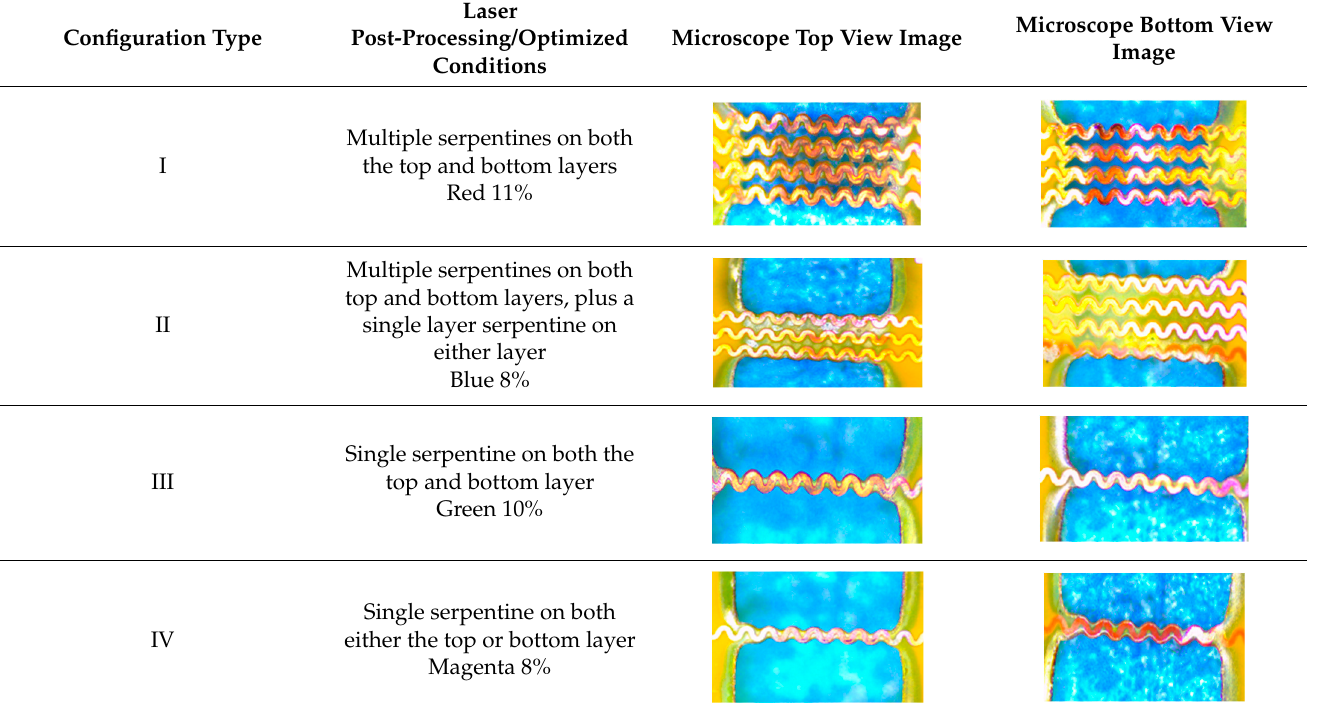
Table 1. Optimized laser postprocessing parameters for all zones for dual-layer fl ex-PCB.